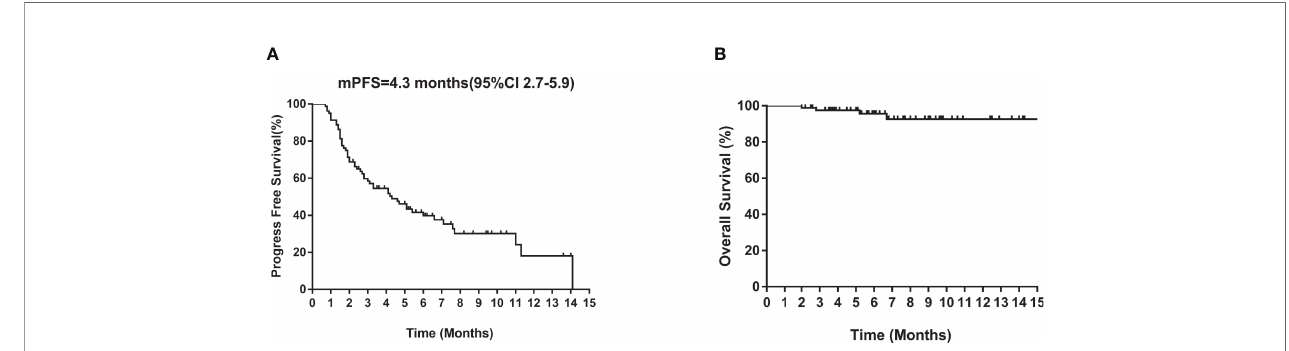
FIGURE 2 | Univariate analysis of PFS in all patients: (A) strati fi ed by EGFR status; (B) strati fi ed by brain metastases; (C) strati fi ed by previous EGFR-targeted therapy.